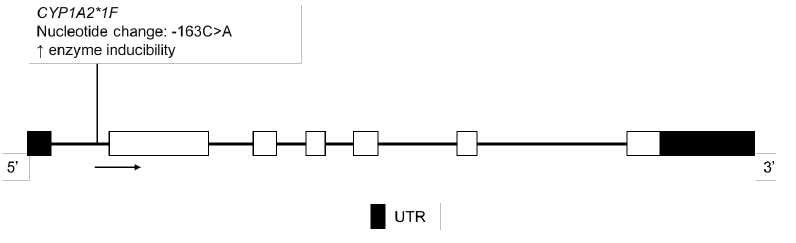
Figure 4. The human CYP1A2 gene and the CYP1A2*1F variant detected in the Amerindian population. Exon 1 is untranslated in CYP1A2. Open boxes represent exons, lines represent introns and shaded boxes represent UTR. Table 3. Comparison of CYP1A2 allele frequencies in Indigenous North American populations to global populations from the 1000 Genomes Project [20]. N represents the number of alleles. Global populations are abbreviated as follows: African Ancestry in Southwest US (ASW); Utah residents with Northern and Western European ancestry (CEU); Han Chinese in Beijing, China (CHB); Mexican Ancestry in Los Angeles, California (MXL).